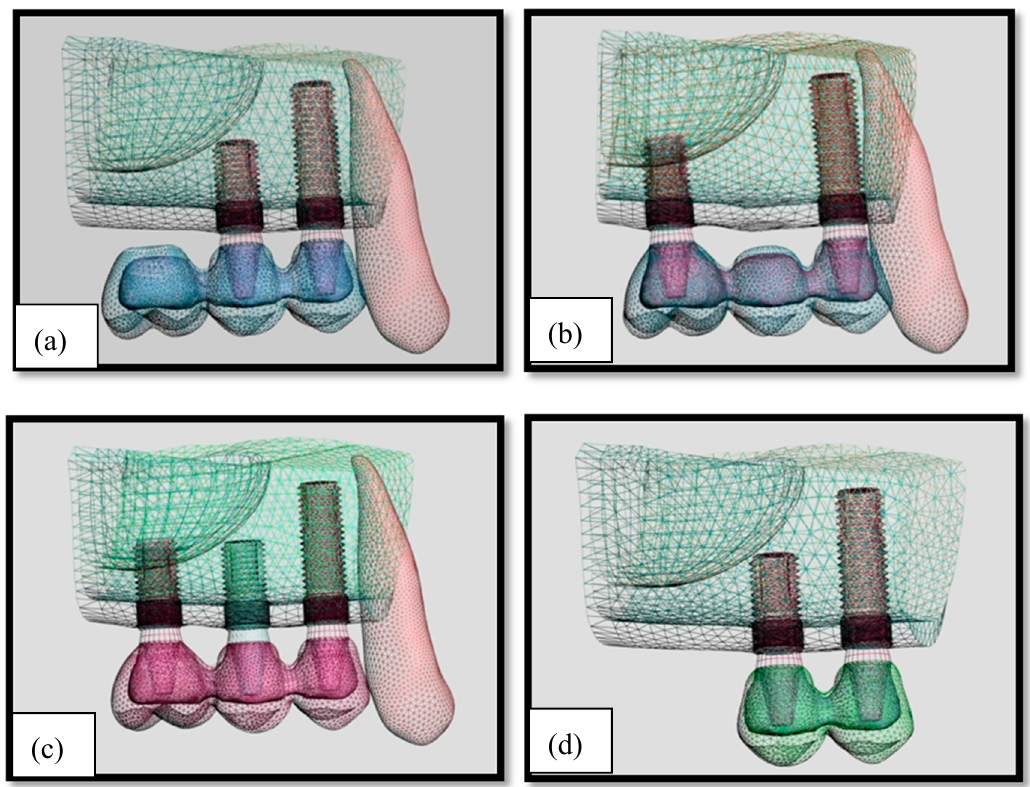
Figure 1. Implant distributions in models. ( a ): Model 1; ( b ): Model 2; ( c ): Model 3; ( d ): Model 4.